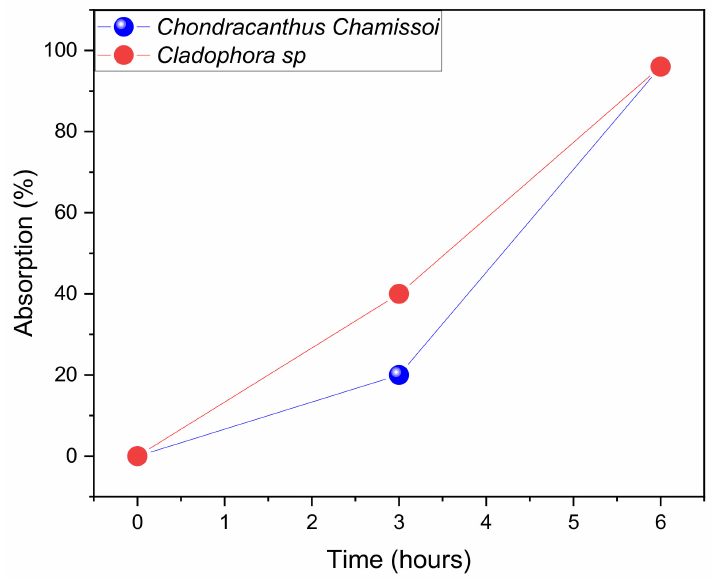
Figure 2. Biosorption percentage of Chondracanthus chamissoi and Cladophora sp. in a 0.25 ppm arsenic solution for 6 h.